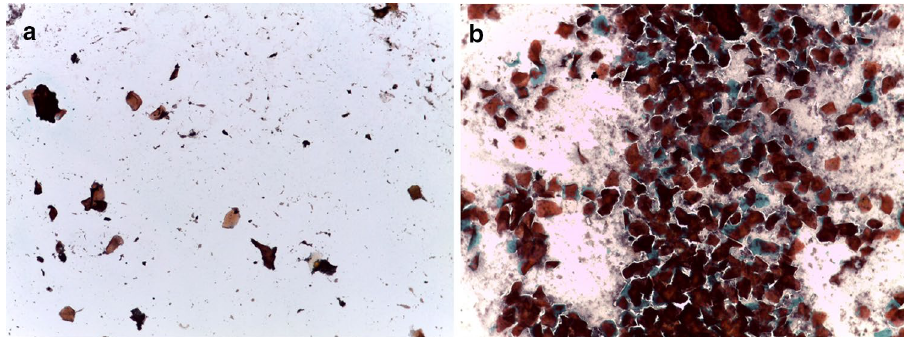
Figure 2. Genital cytology data confirming that females experienced regular receptive cycles. In comparison to the pre-ovulatory phase ( a ), the post-ovulatory phase ( b ) is marked by the return of leukocytes and mucus, as well as clumped, curled and folded cells and, quite commonly, placard or rosette arrangements of